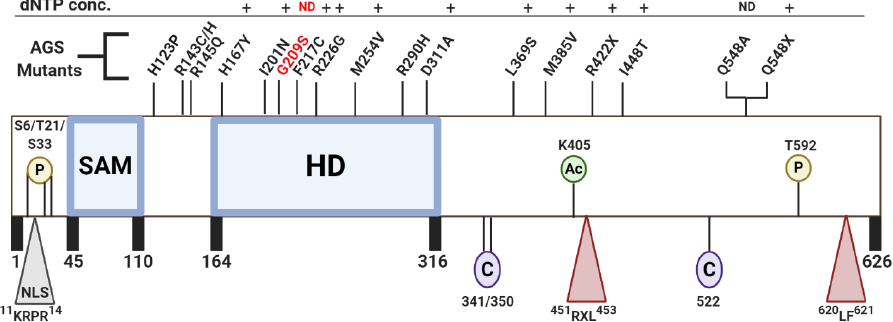
Figure 2. Key SAMHD1 domains, residues, and AGS mutants. SAMHD1 contains an N-terminal SAM domain, central catalytic HD domain, and C-terminus containing an 451 RXL 453 and 620 LF 621 cyclin- binding motif that is essential for recognition and subsequent phosphorylation of T592 by CDK1/2. SAMHD1 contains a classic NLS sequence (11-KRPR-14), a residue that can undergo acetylation (K405), and at least four residues that can undergo phosphorylation (S6, T21, S33, and well-known T592). Lastly, a triad of surface-exposed, oxidizable cysteines (C341, C350, and C522) have been found to influence protein function. SAMHD1 mutations identified in AGS patients are labeled and distributed along the top of the SAMHD1 schematic. In White et al. (2017), the dNTP concentrations of U937 cells were measured following the transduction of different SAMHD1 AGS mutants. Here, the mutants are summarized to have more (+) or no difference (ND) in dNTP pools relative to wildtype hSAMHD1. SAMHD1 mutants that do not have a symbol assigned represent the population that were not able to be tested. The mutant G209S (highlighted red) represents the only variant found to restrict HIV-1.